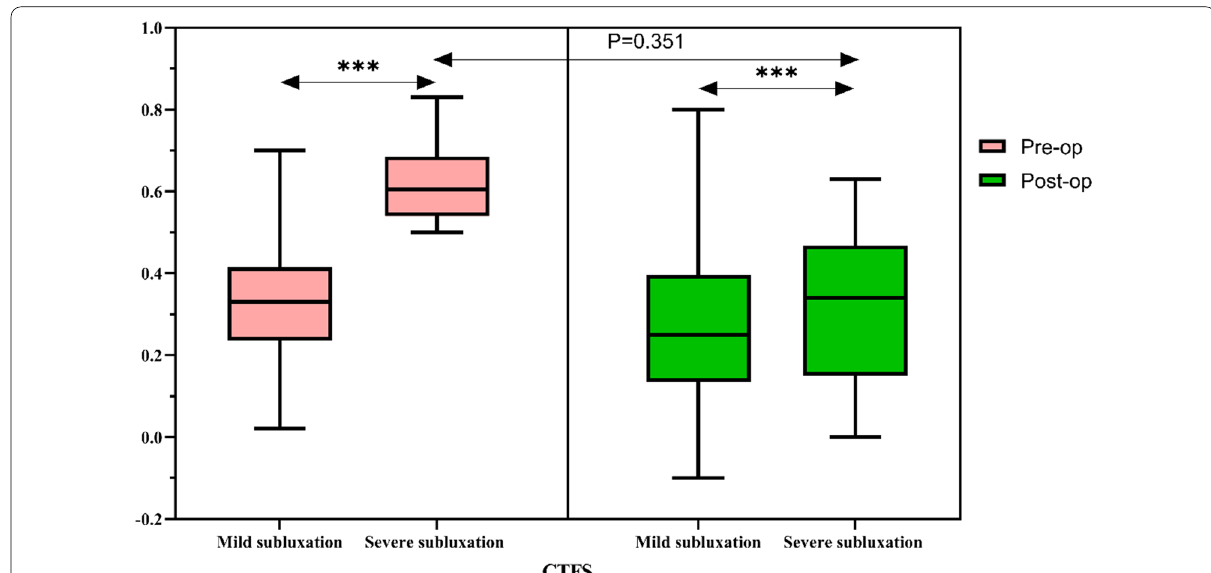
Fig. 4 Comparison of FTA in the three subluxation